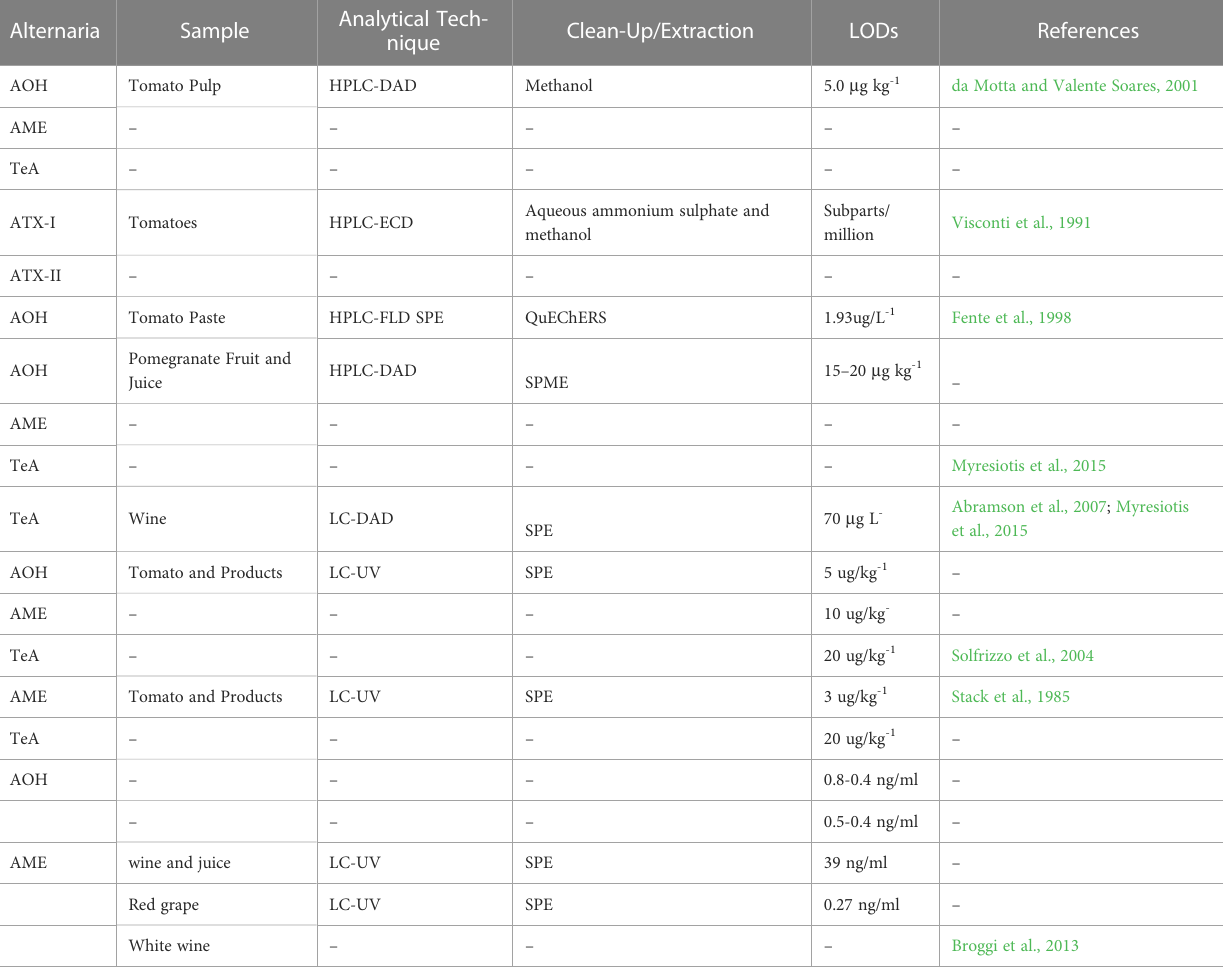
TABLE 4 Alternaria mycotoxin detection using LC-UV/DAD/FLD/ECD/ELSD.